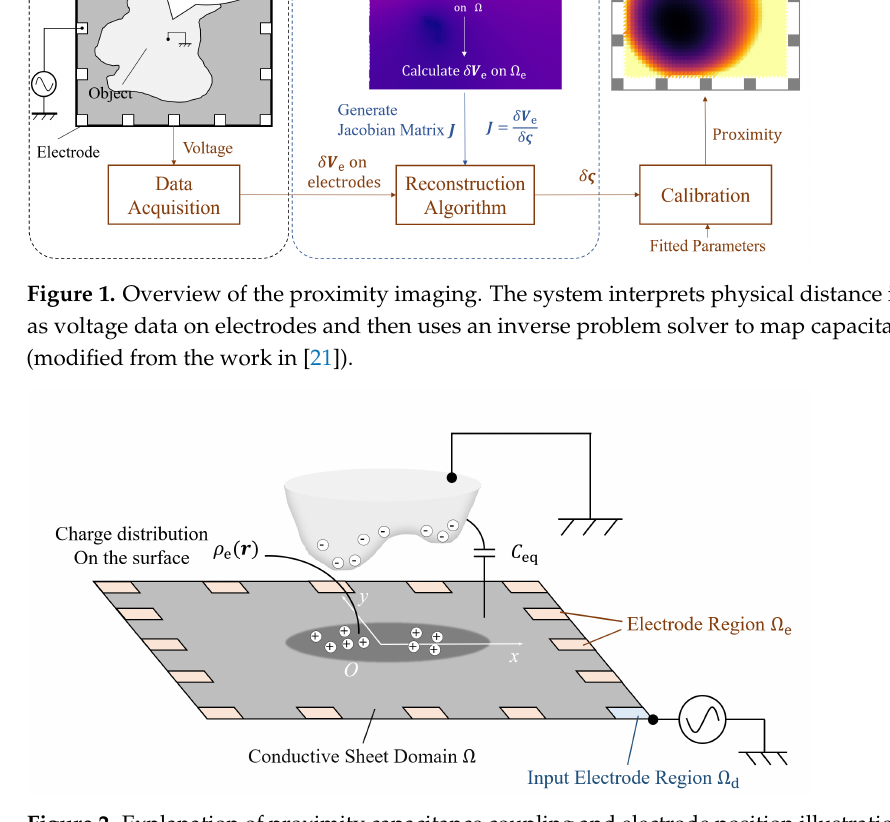
Figure 2. Explanation of proximity capacitance coupling and electrode position illustration (modified from the work in